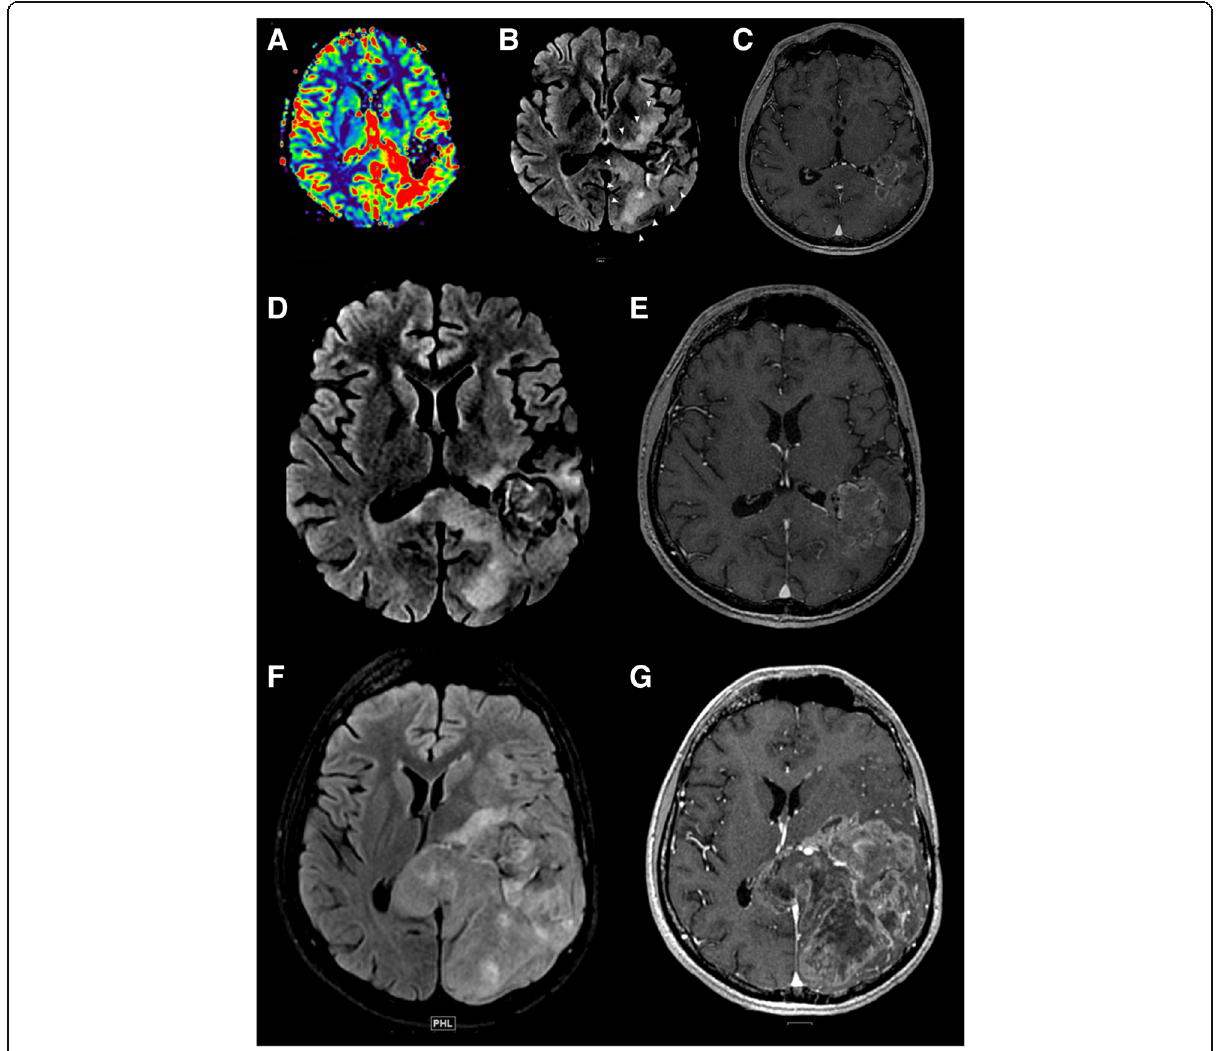
Fig. 2 Detection of a potential hyperprogression in a patient with glioblastoma. This case illustrates the potential risk of hyperprogression. Imaging of an 18 year old patient with a diagnosis of glioblastoma treated with anti-PD-1. MRIs were obtained at 3-month intervals (baseline, a – e ; 3 months, f , g ). a – e Baseline T1 post-contrast MRI prior to immunotherapy and re-gamma knife therapy demonstrating an enhancing lesion with increased perfusion. f , g MRI post-initiation of immunotherapy showing fast interval growth of the lesion, as well as a life-threatening mass effect. This case illustrates the potential life-threatening local complications of